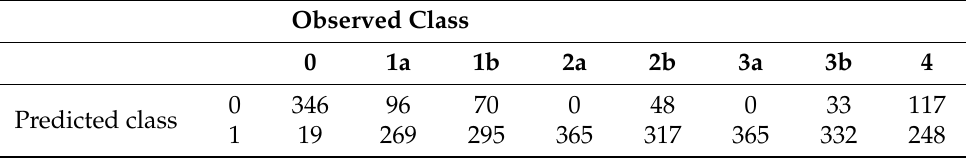
Table 10. Detailed confusion matrix for the one-class model separated by the original scenarios